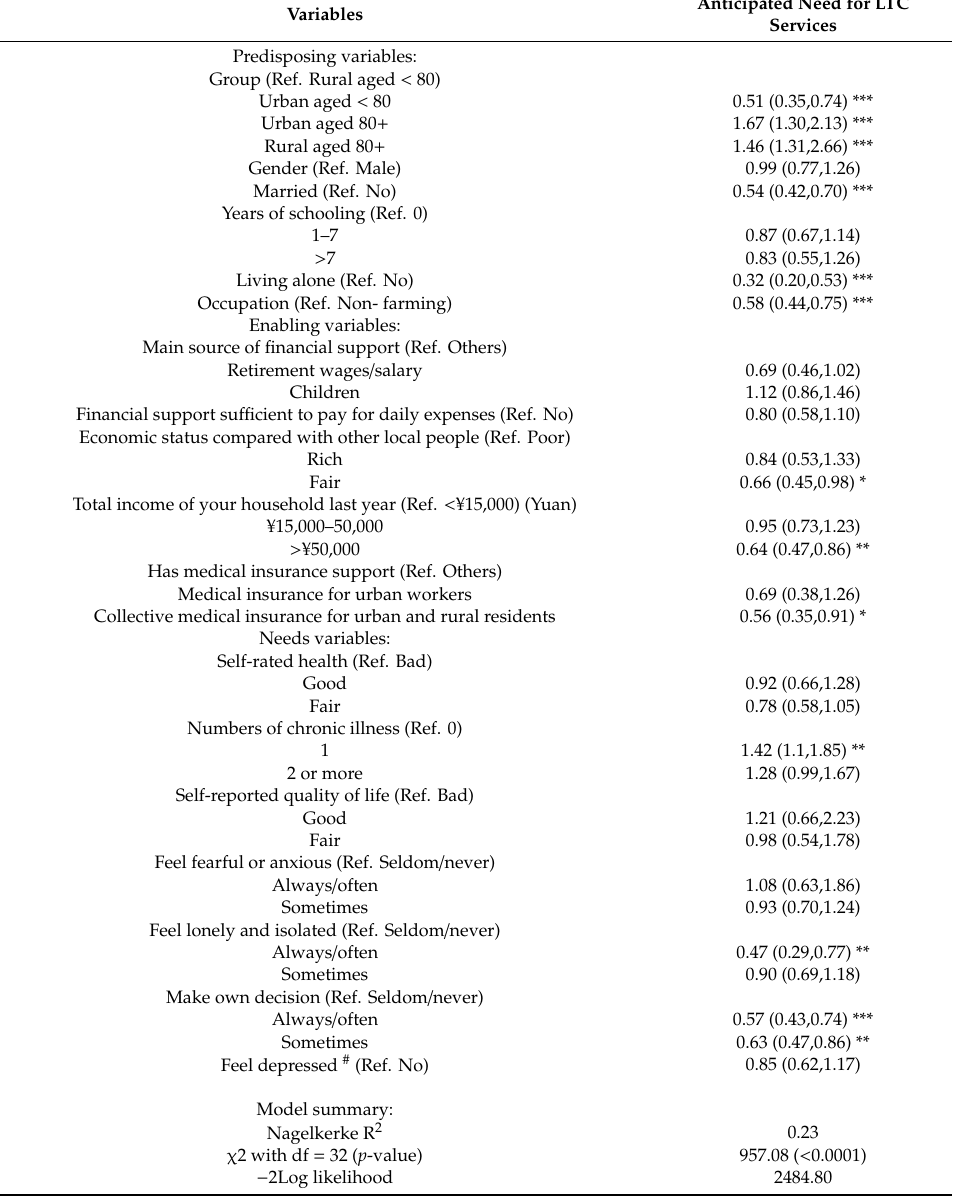
Table 4. Odds ratios of the anticipated needs for LTC services (binary logistic